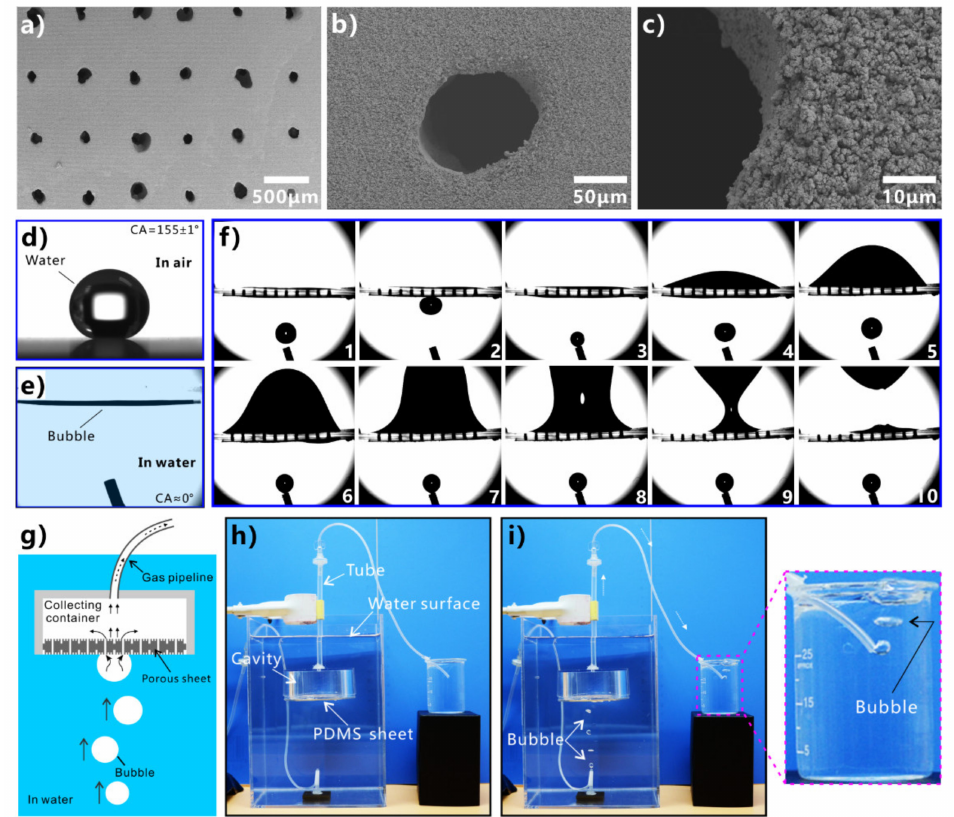
Figure 31. Underwater bubble-collection device composed of superhydrophobic and underwater superaerophilic porous sheet. ( a – c ) Morphology of the microholes and rough surface microstructures on the PDMS sheet. ( d ) A small drop of water on the structured sheet in the air. ( e ) Underwater air bubble on the structured sheet. ( f ) Passage of bubbles through the porous superwetting sheet in water. ( g ) Schematic of the designed collection device. ( h ) Photo of the artificial bubble-collection device. ( i ) Collection of bubbles from water. Reprinted with permission from ref. [342]. Copyright 2018, The Royal Society of